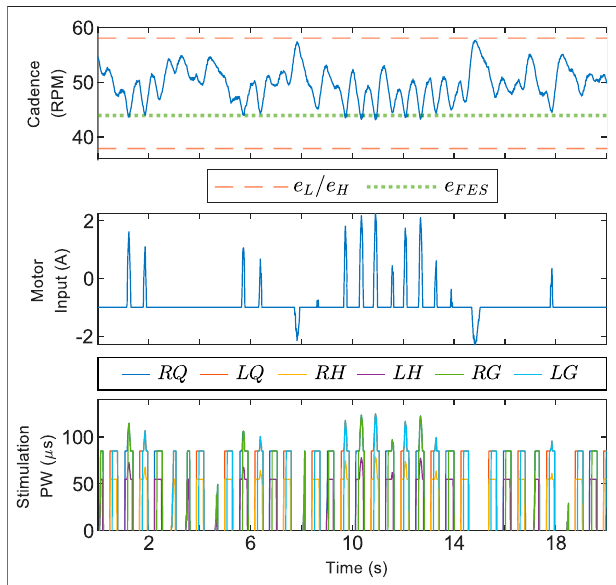
FIGURE 5 | Segment of a trial using Protocol B, where alternative parameters for the barrier function controller were used. The safe set was much wider for this run, leading to less deviation of control inputs from the nominal value. Nonzero nominal inputs were used to intensify the training. The data was collected with Participant #2.